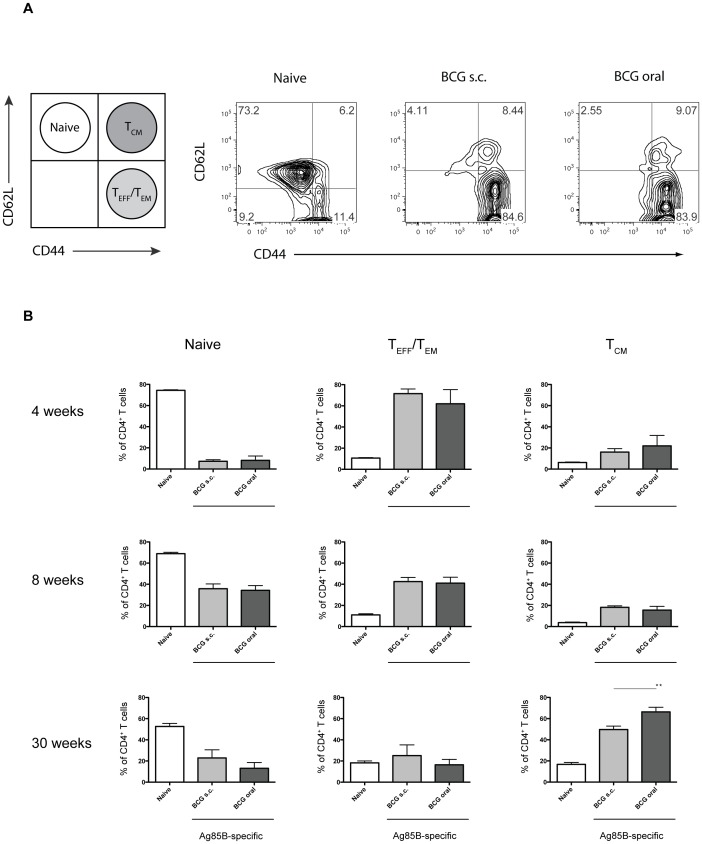
Oral vaccination with Liporale™ BCG induces effector and central memory Ag85B-specific CD4+ T cells in the spleen.Lymphocytes from the spleens of naïve, Liporale™-BCG vaccinated (BCG oral) or subcutaneously vaccinated (BCG s.c.) mice were stained with an Ag85B/MHCII tetramer and enriched for tetramer positive cells by magnetic bead isolation. (A) Representative flow cytometry density plots showing CD62L and CD44 expression on total CD4+ T cells from spleens of naïve mice, or Ag85b-specific CD4+ T cells from the spleens of BCG vaccinated mice. (B) Bar graphs showing the proportion of naïve (CD62Lhi, CD44lo), TEFF/TEM (CD62Llo, CD44hi) or TCM (CD62Lhi, CD44hi) CD4+ T lymphocytes of total CD4+ T cells from naïve mice or Ag85B-specific CD4+ T cells from the spleens of BCG vaccinated mice at 4, 8 and 30 weeks post vaccination. Results are displayed as mean + SEM of n = 5 for each group: *p<0.05, **p<0.01, ***p<0.001 (Mann-Whitney test). Eight and 30 weeks results are representative of 2 independent experiments.